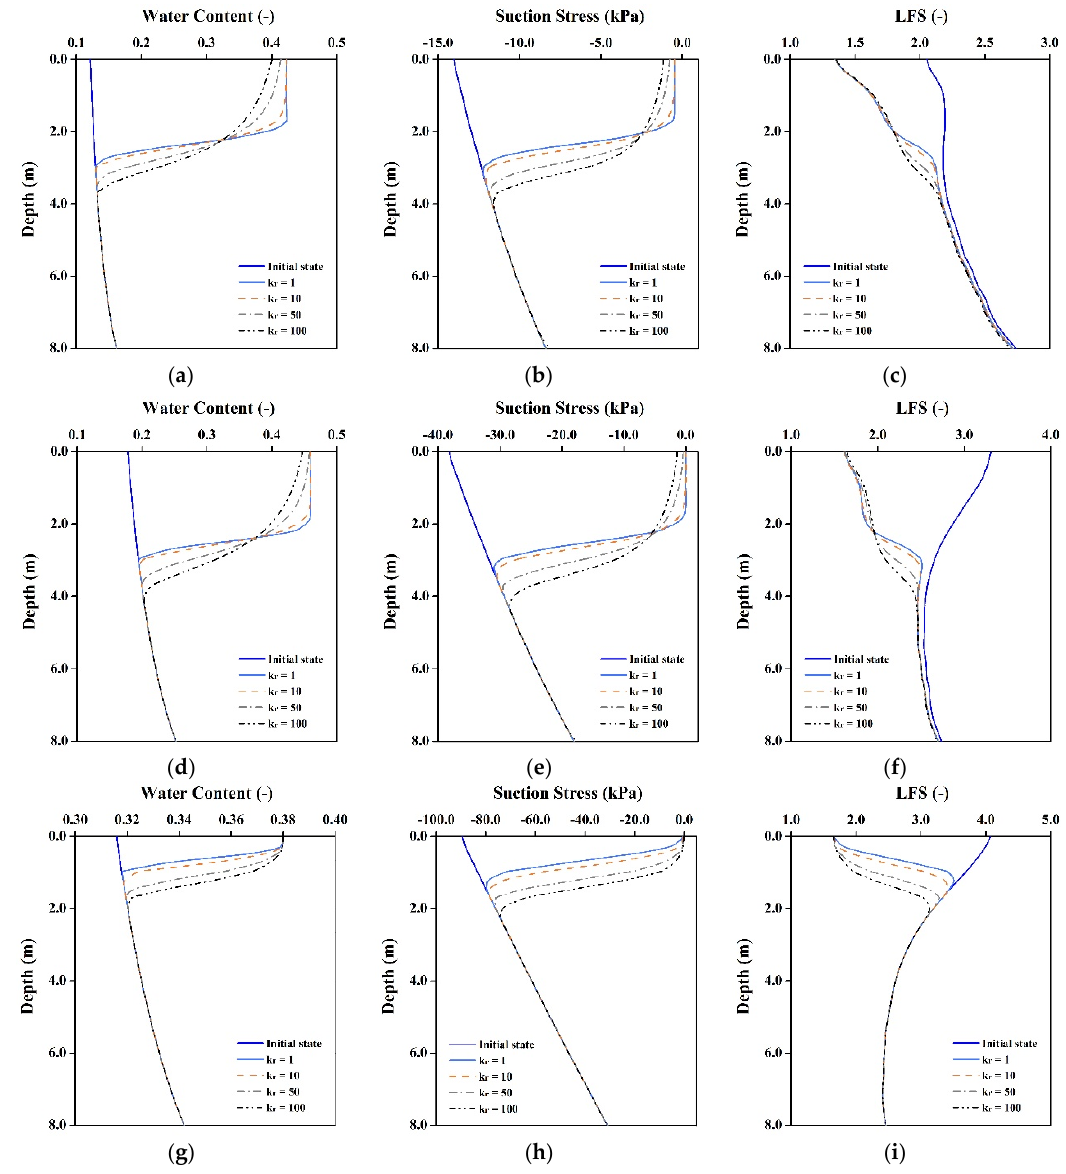
Figure 6. Results of rainfall infiltration in various hydraulic conductivity anisotropy cases on the slope (Y ‐ Y’). Changes in ( a , d , g ) Water content; ( b , e , h ) Suction stress; and ( c , f , i ) LFS for loam, silt and clay slopes, respectively. ( a ) Loam; ( b ) Loam; ( c ) Loam; ( d ) Silt; ( e ) Silt; ( f ) Silt; ( g ) Clay; ( h ) Clay; ( i ) Clay.